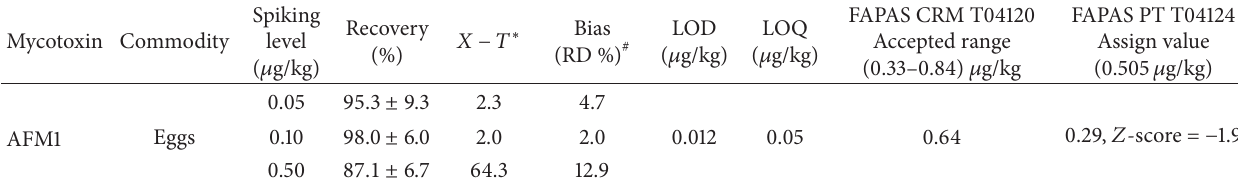
Table 1: Trueness calculations and recoveries (mean ± SD, 𝑛 = 6 ) for 3 spiking levels in eggs, LOD, LOQ, CRM 1 , and PT 2 for